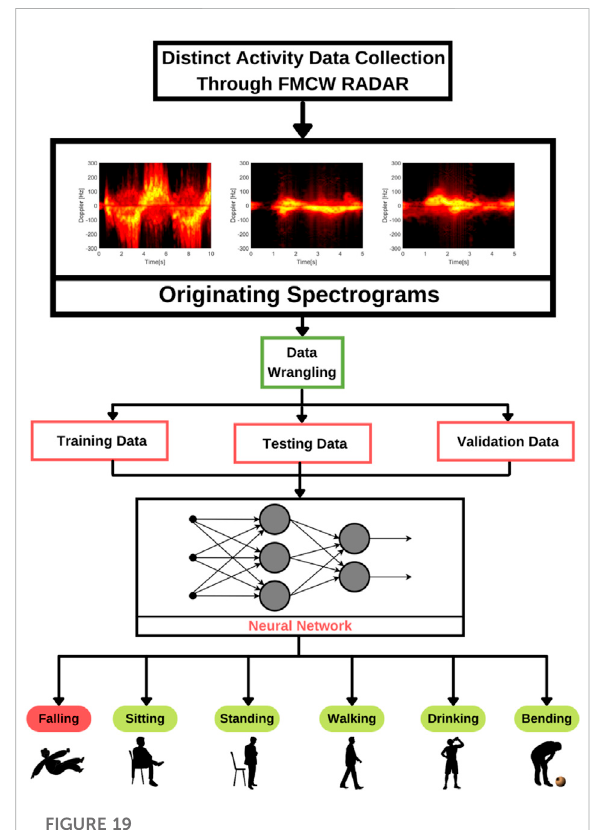
FIGURE 19 Overall methodology for activity monitoring using the FMCW radar (Taylor et al., 2021).